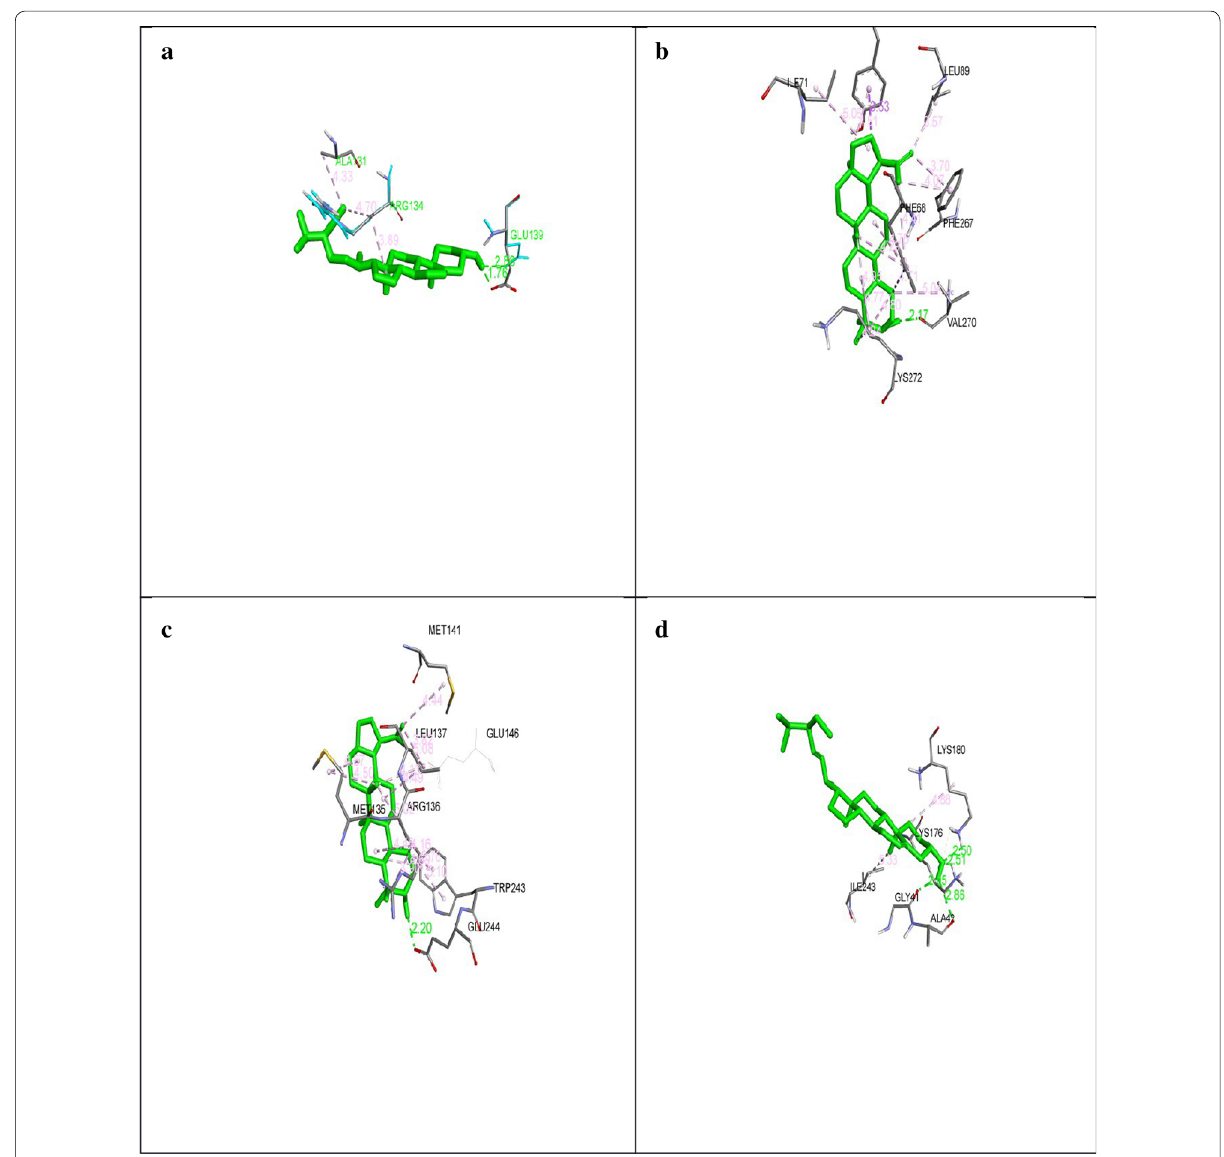
Fig. 6 Various ligand/macromolecule docking interactions a interactions between betasitosterol and 5E2F involving two H-bonds with Glu139, b indicate lupeol interaction involving one H-bond with 4OX3, c represents interactions between lupeol and 1W5D with one H-bond, d represents stigmasterol and 3MFD forming four